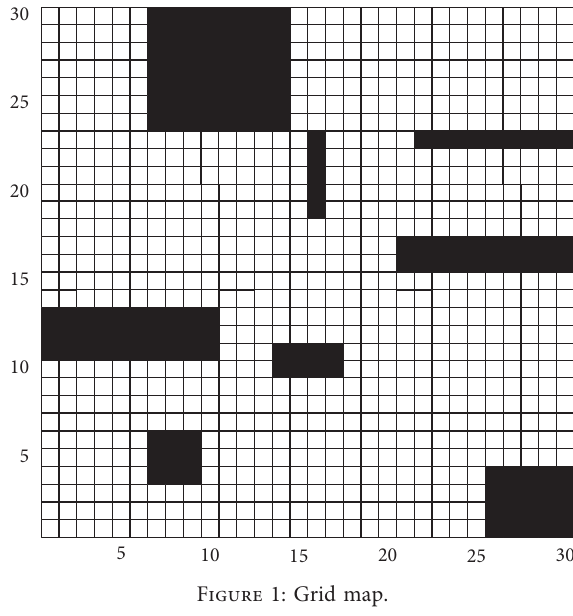
Figure 1: Grid map.